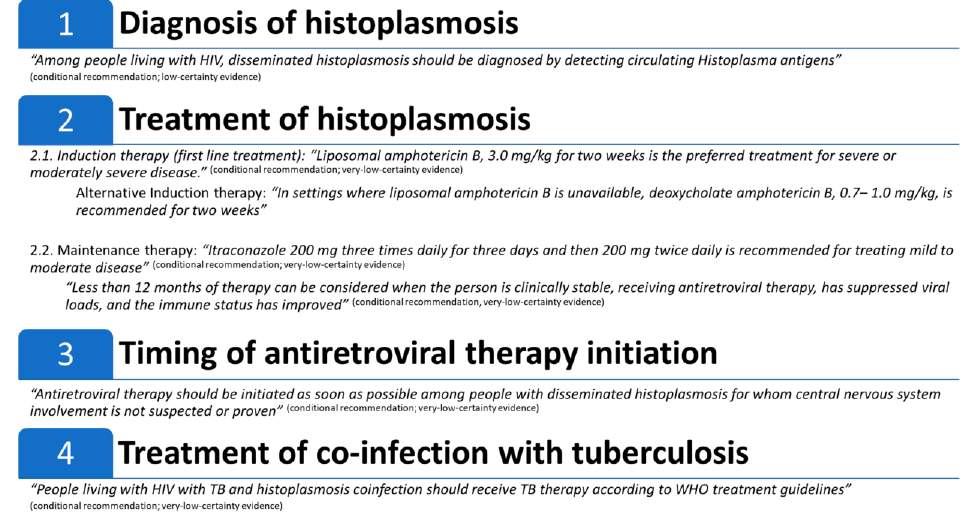
Figure 2. Summary of: Pan American Health Organization (PAHO)/World Health Organization (WHO) guidelines for diagnosing and managing disseminated histoplasmosis among people living with